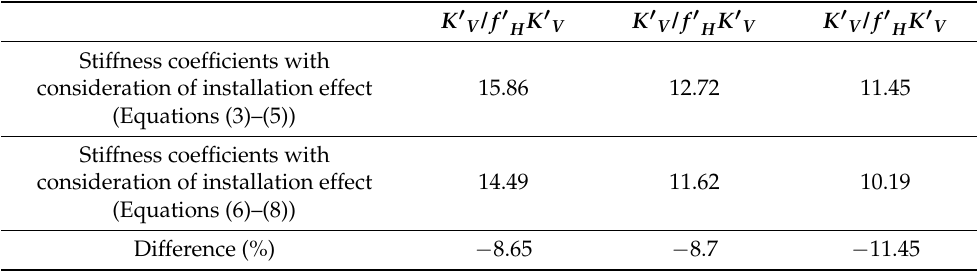
Table 14. Effect of spudcan installation on dimensionless initial stiffness